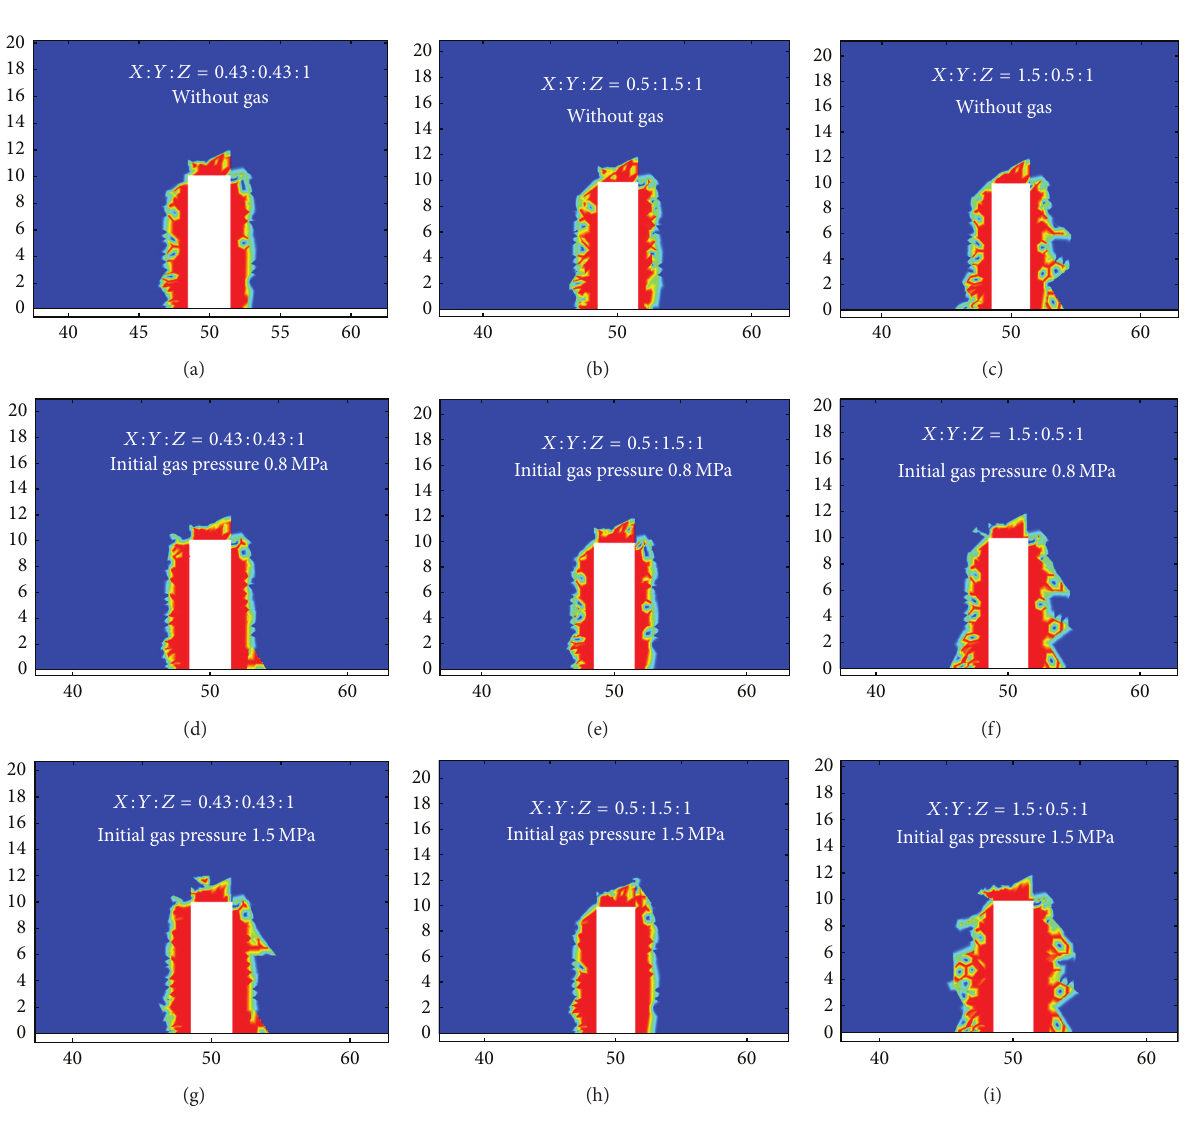
Figure 4: The plastic zone of the coal mass surrounding the roadway.